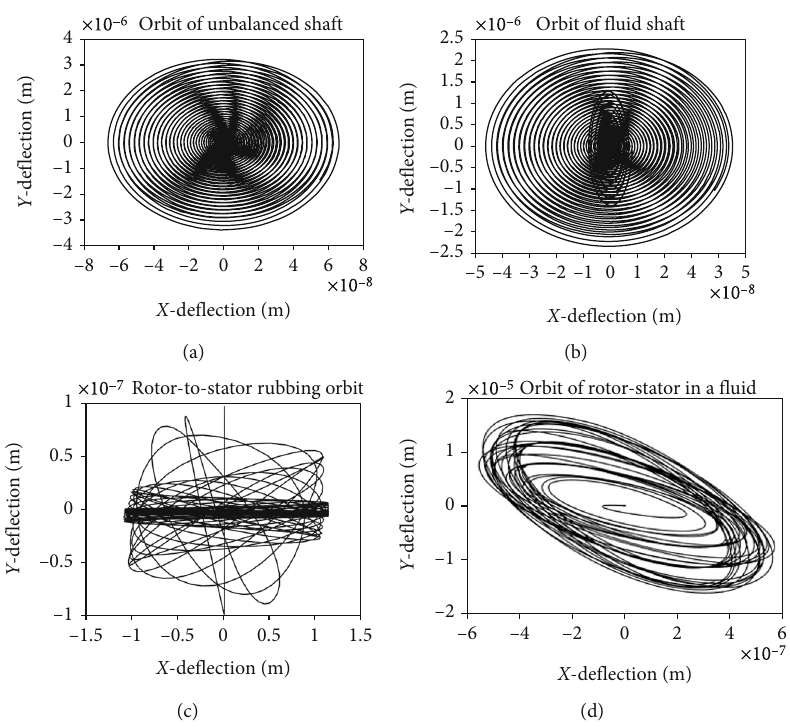
Figure 4: Orbits of the shaft in various conditions near the fi rst critical